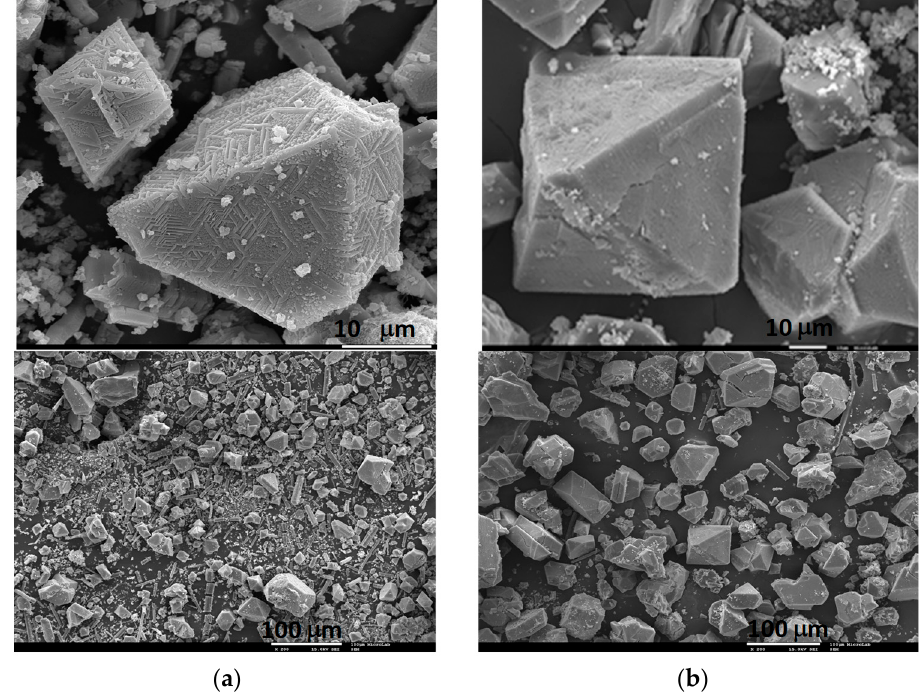
Figure 6. SEM images of ( a ) Cu-BTC and ( b ) [EMIM][OTf]@Cu-BTC composite.